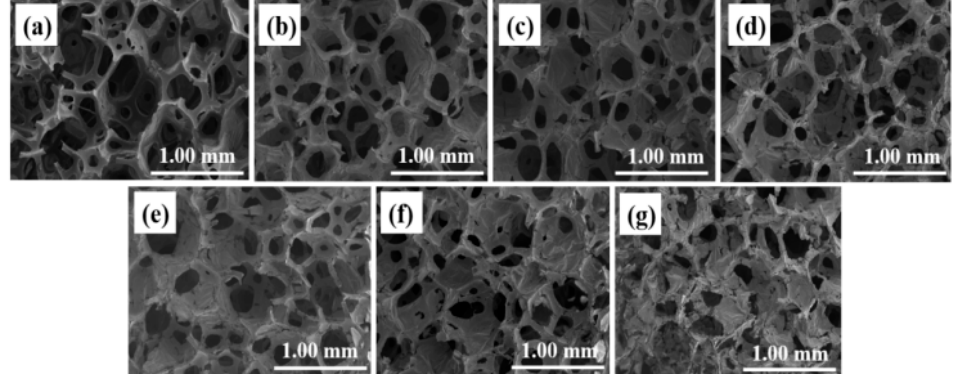
Figure 3. Scanning electron microscopy images of samples with different plating times: ( a ) unplated, ( b ) 1 min, ( c ) 1.5 min, ( d ) 2 min, ( e ) 4 min, ( f ) 8 min, and ( g ) 10 min.